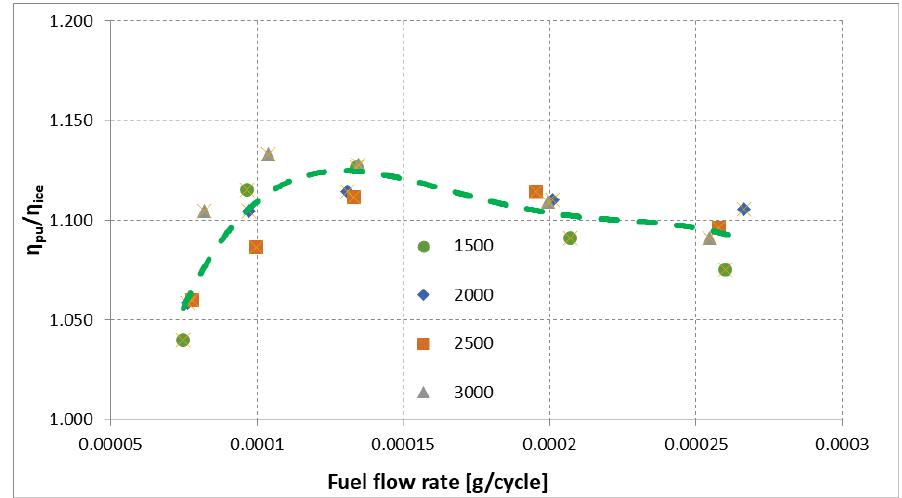
Figure 7. Power unit e ffi ciency η PU compared to ICE e ffi ciency without turbocompound η ICE , as a function of fuel flow rate (g / cycle). Marks correspond to ICE speed (rpm).